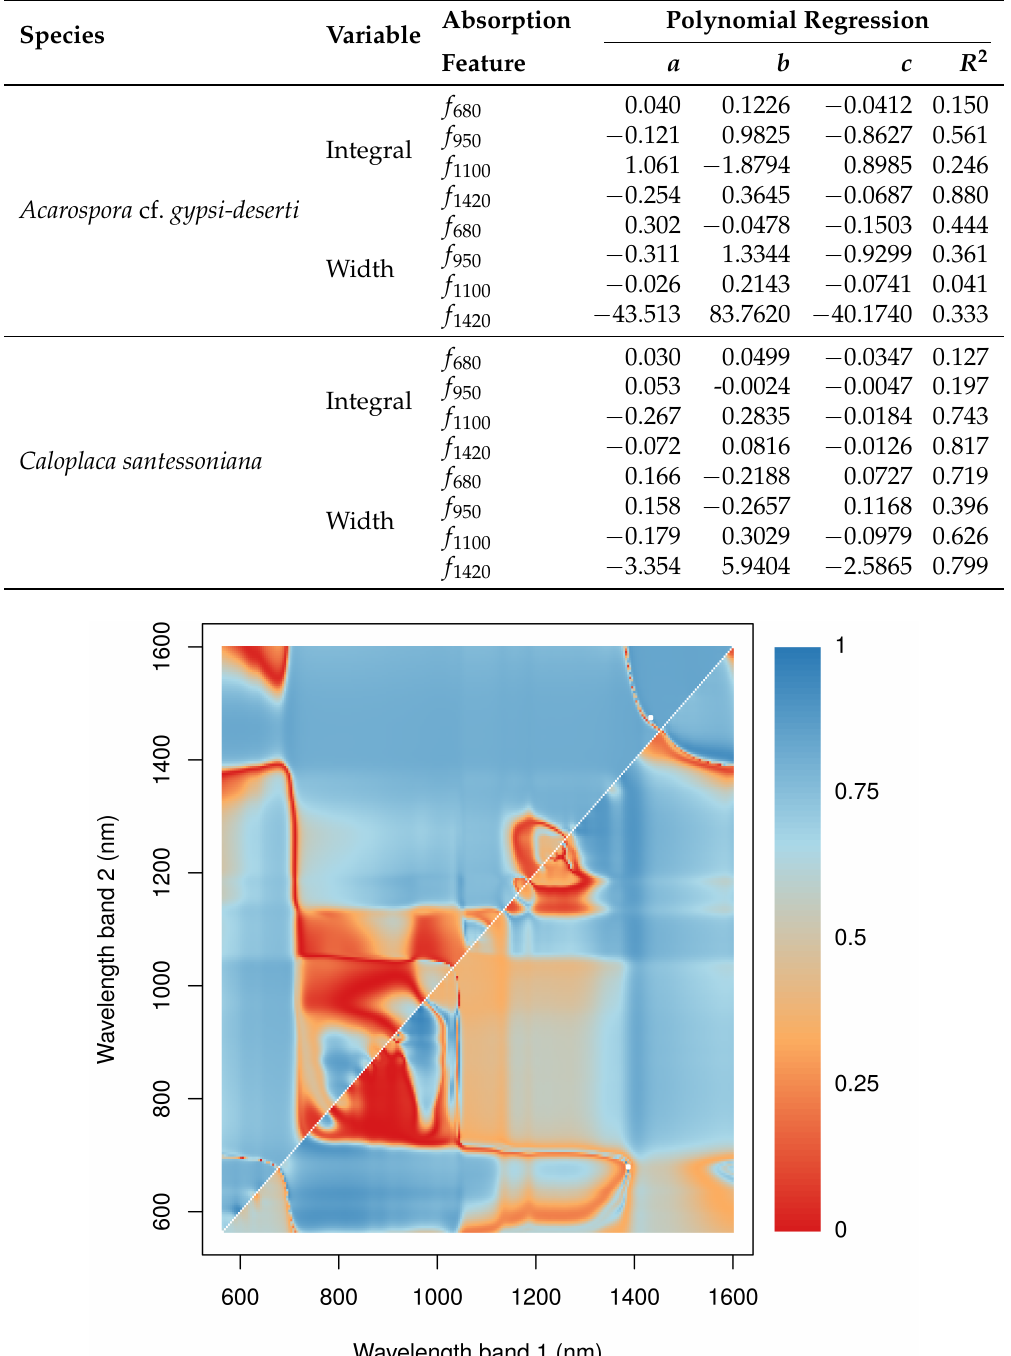
Table 2. Summary of the models for Acarospora cf. gypsi-deserti and Caloplaca santessoniana between net photosynthesis (NP) and continuum removal derived variables.